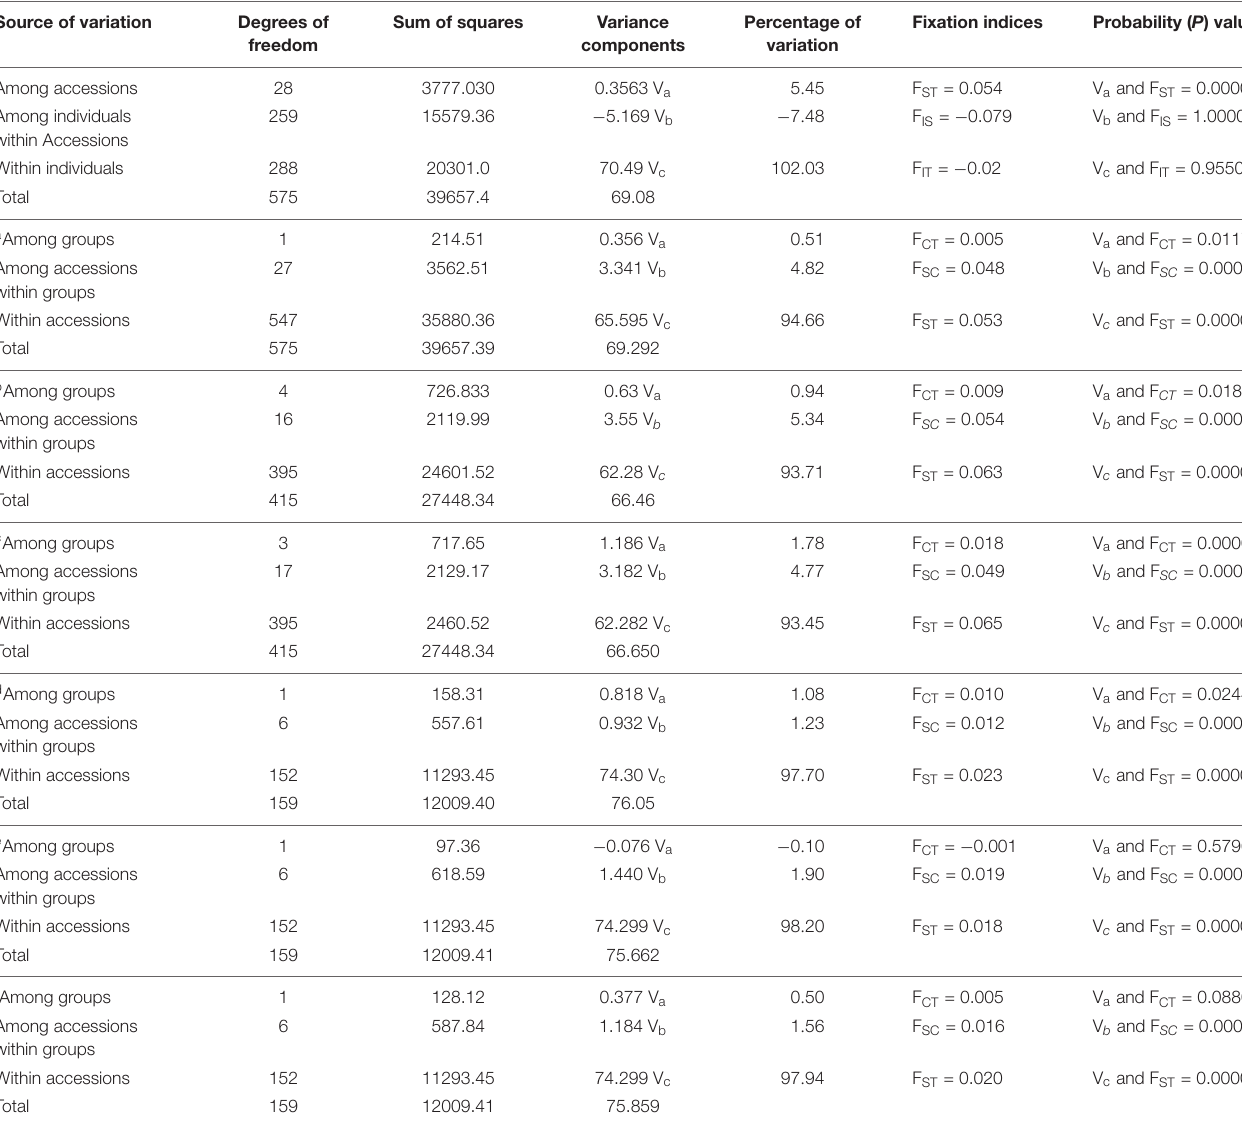
TABLE 2 | Summary of analysis of molecular variance (AMOVA) based on 1000 permutations for (1) all 29 accessions without grouping, and by grouping (2) the 21 accessions from NordGen, and (3) the eight Lantmännen accessions. Source of variation Degrees of Sum of squares Variance Percentage of freedom components